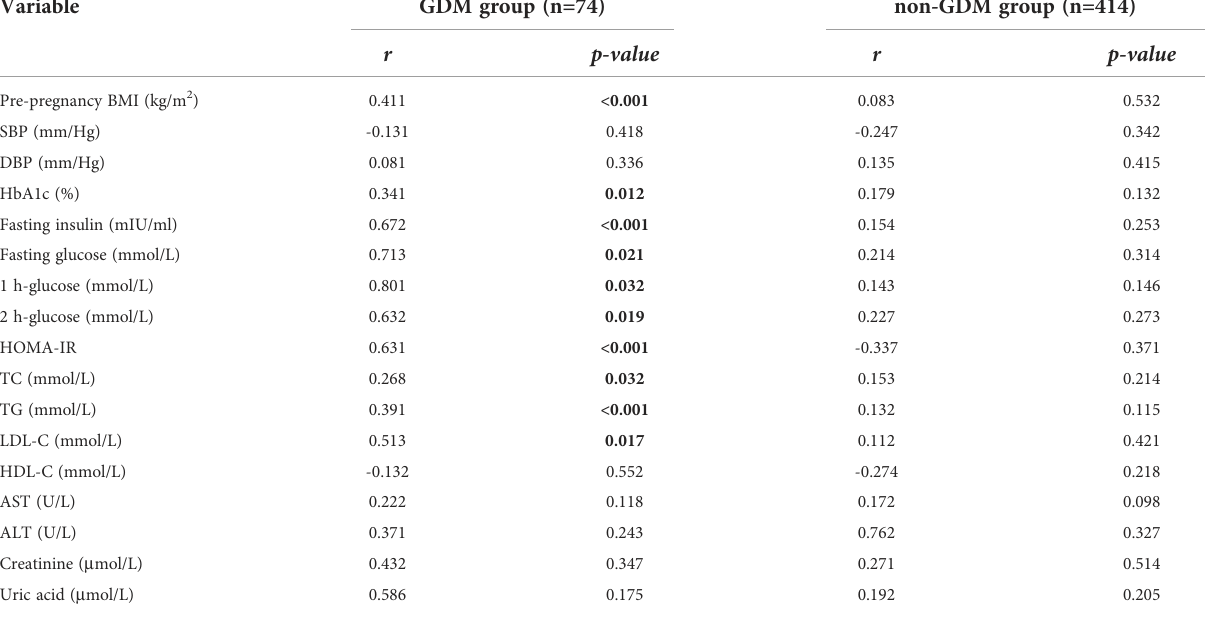
TABLE 2 Correlations between serum NGAL levels and clinical and laboratory parameters in the two groups.